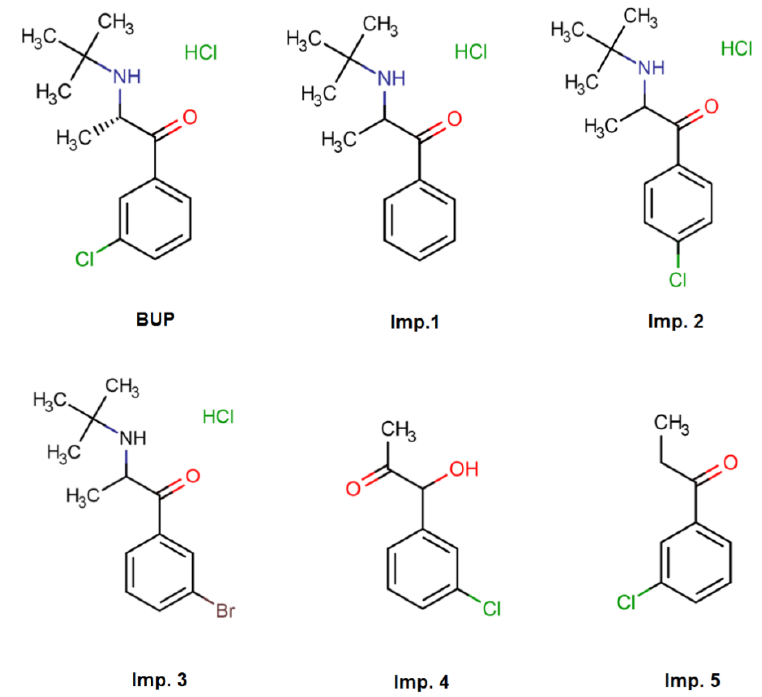
Figure 1. Chemical structures of BUP and its 5 impurities.